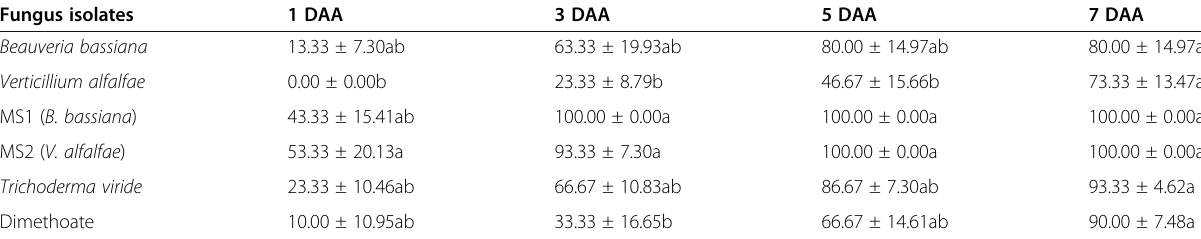
Table 1 Mortality rates resulting from applications of EPF and secondary metabolites at a concentration of 10 7 conidia ml − 1 to